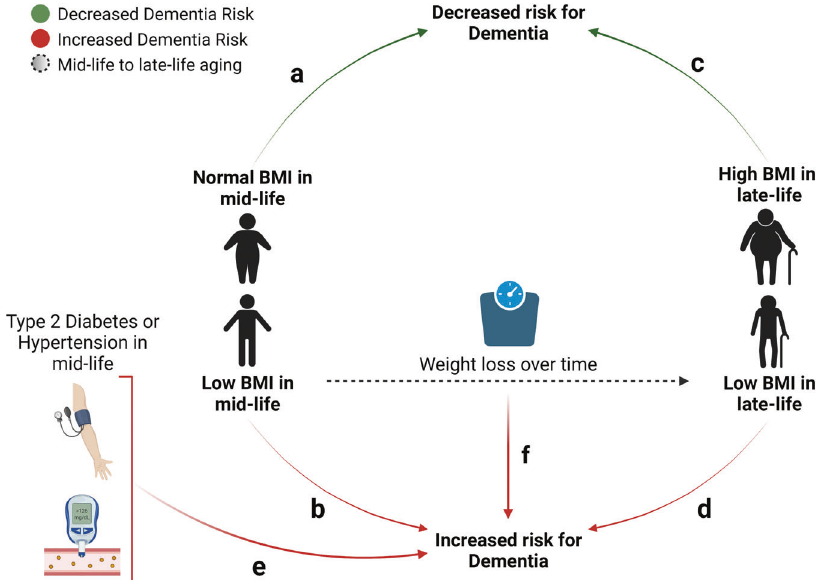
Fig. 1 Schematic of obesity paradox, revealed in retrospective clinical studies. A retrospective study conducted on 2 million people over 40 years-of-age showed that underweight people had the highest risk for dementia compared to individuals with a healthy weight in mid-life ( a vs. b ), while overweight individuals had the lowest risk for developing AD in late life ( c vs. d ) [17, 18]. This observation con fl icts with the evidence that cardiovascular risk factors, including hypertension and type 2 diabetes, both commonly linked to obesity, strongly associate with an increased risk for developing dementia ( e ) [11 – 15]. This paradox is even more complex with the reported fi nding that more than a 10% loss in weight within 5 years between mid- and late-life is also associated with a 50% increased risk of developing dementia ( f ) Deleterious effects of dietary fat consumption on AD pathophysiology in animal models AD mouse models with APP and PS1 mutations APP/PS1 mouse line: The association between HFD consumption and AD has been studied in different AD mouse models, which replicate key pathologies documented in AD patients, including A β accumulation, tau hyperphosphorylation, neuroin fl ammation, and cognitive decline. Many mouse models of AD focus on one aspect of AD pathophysiology — the accumulation of A β in the brain. For example, APP/PS1 mice, which express human transgenes for APP with the Swedish mutation (K670N/M671L) and PS1 with the L166P mutation under the control of the neuronal-speci fi c Thy1 promoter, are a widely used model of accelerated A β accumulation, which makes them a suitable model